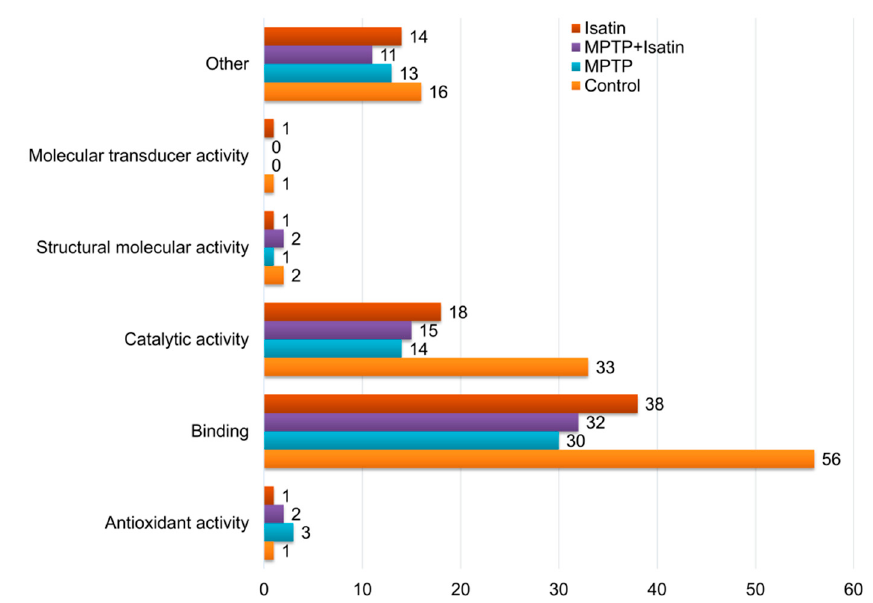
Figure 1. Distribution of identified ubiquitinated proteins among GO groups. Numbers designate the number of identified ubiquitinated proteins in each experimental group of animals.